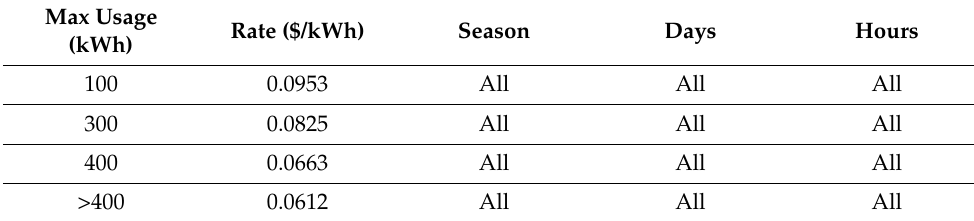
Table A4. Rate C (City of Independence)—tiered.